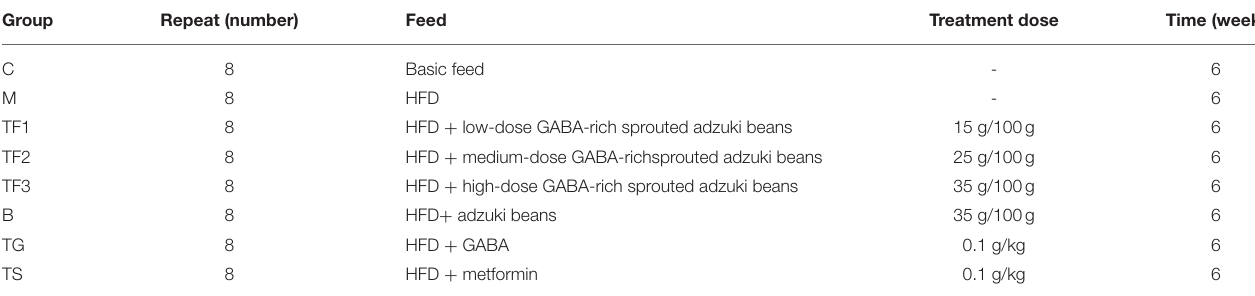
TABLE 1 | Animal experiment group.